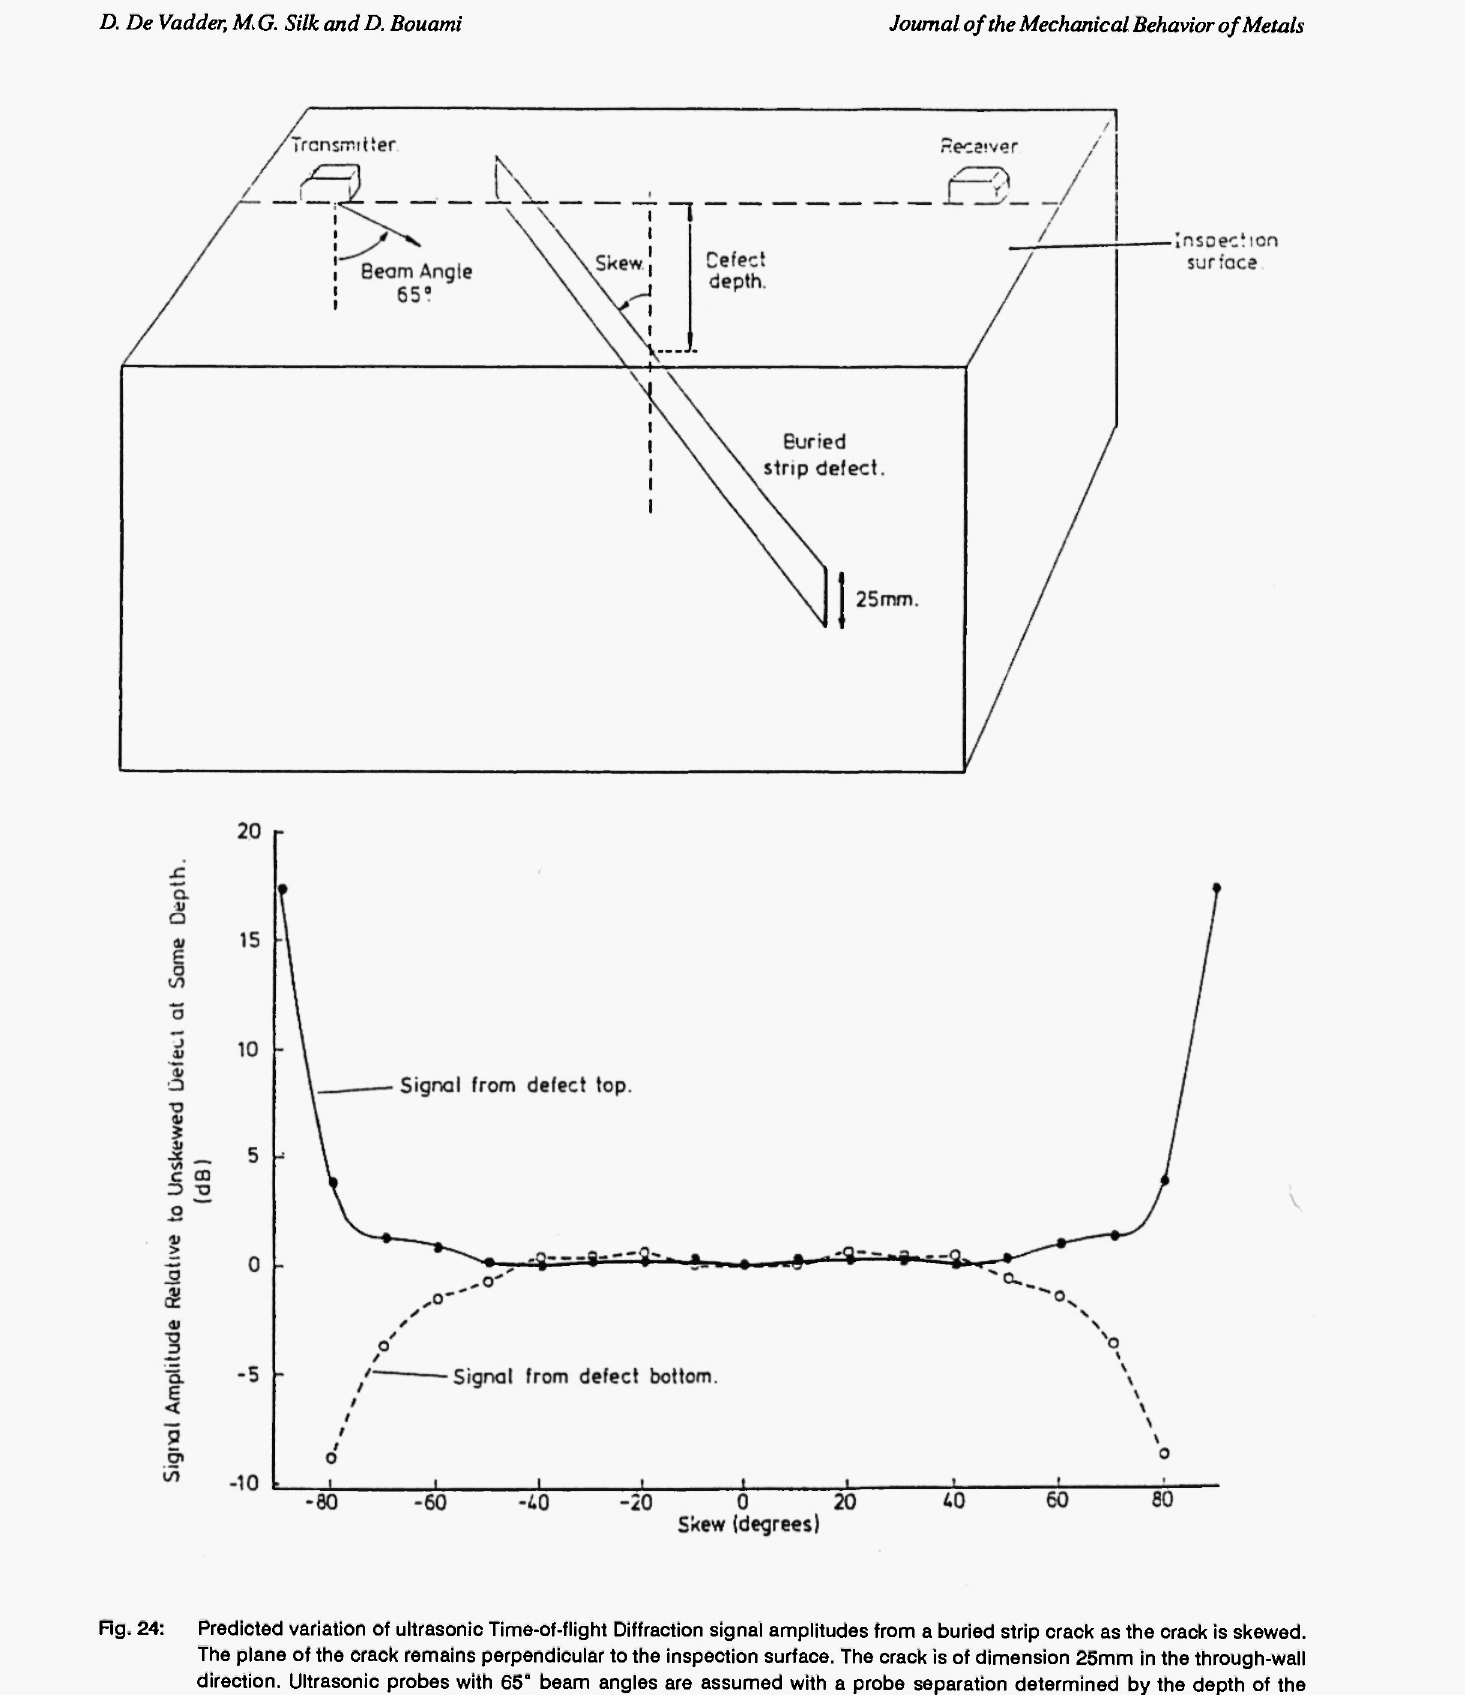
Fig. 24: Predicted variation of ultrasonic Time-of-flight Diffraction signal amplitudes from a buried strip crack as the crack is skewed. The plane of the crack remains perpendicular to the inspection surface. The crack is of dimension 25mm in the through-wall direction. Ultrasonic probes with 65° beam angles are assumed with a probe separation determined by the depth of the defect